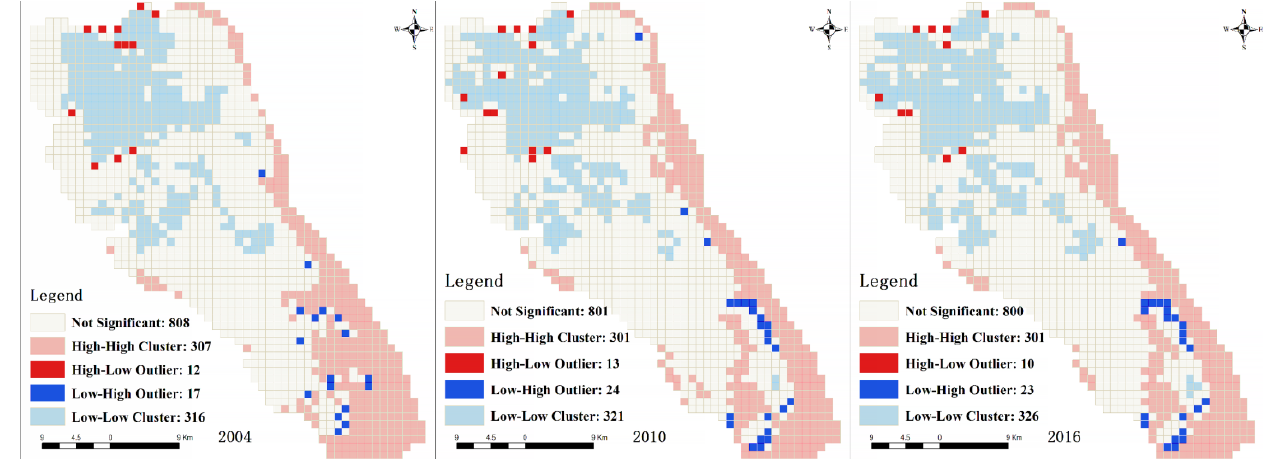
Figure 7. The local spatial autocorrelation analysis cluster graph of ESD.